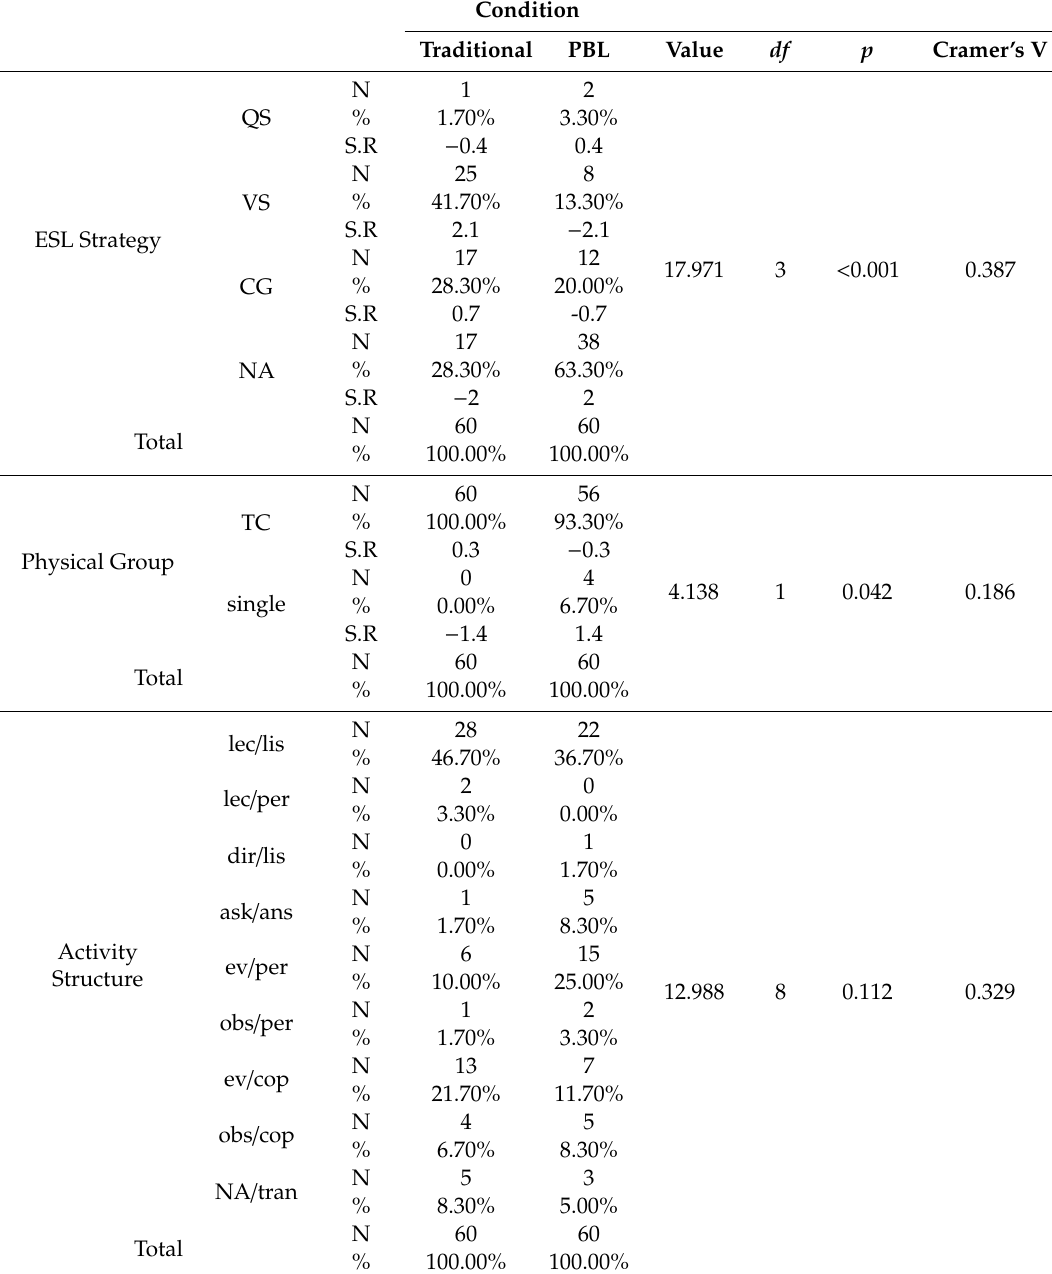
Table 3. Chi-square statistics of the instructor’s pedagogical behaviors in the writing module between the PBL and traditional